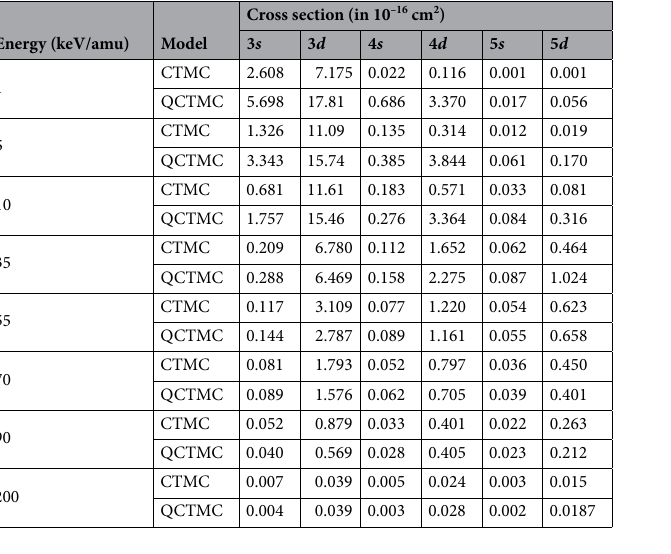
Table 1. The present CTMC and QCTMC results of the electron capture cross sections into specific states of the projectile in Be 4+ + H(1 s ).